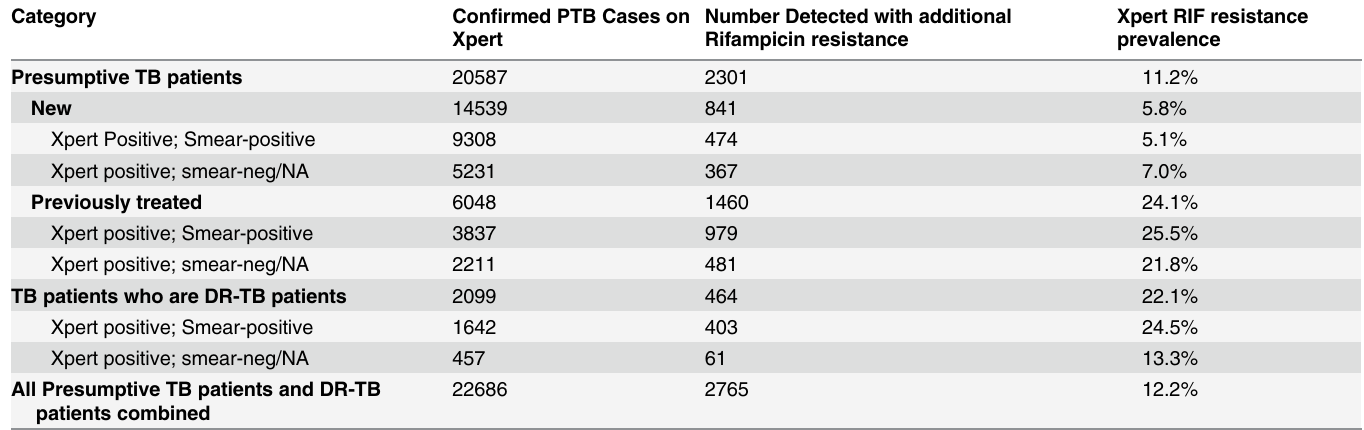
Table 4. Numbers and proportion of tuberculosis patients with rifampicin resistance detected with Xpert MTB/RIF across all 18 study TUs in inter- vention phase.